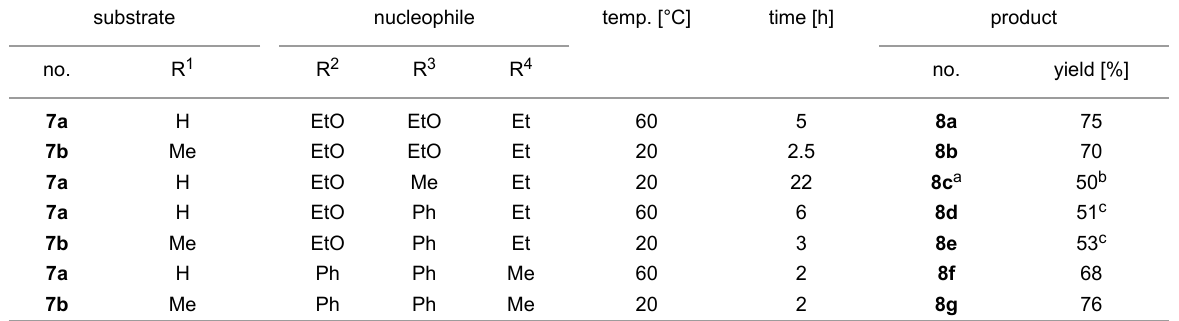
Table 3: Reaction of diethyl 1-( N -acetylamino)-1-triphenylphosphoniumalkylphosphonate tetrafluoroborates 7 with phosphorus